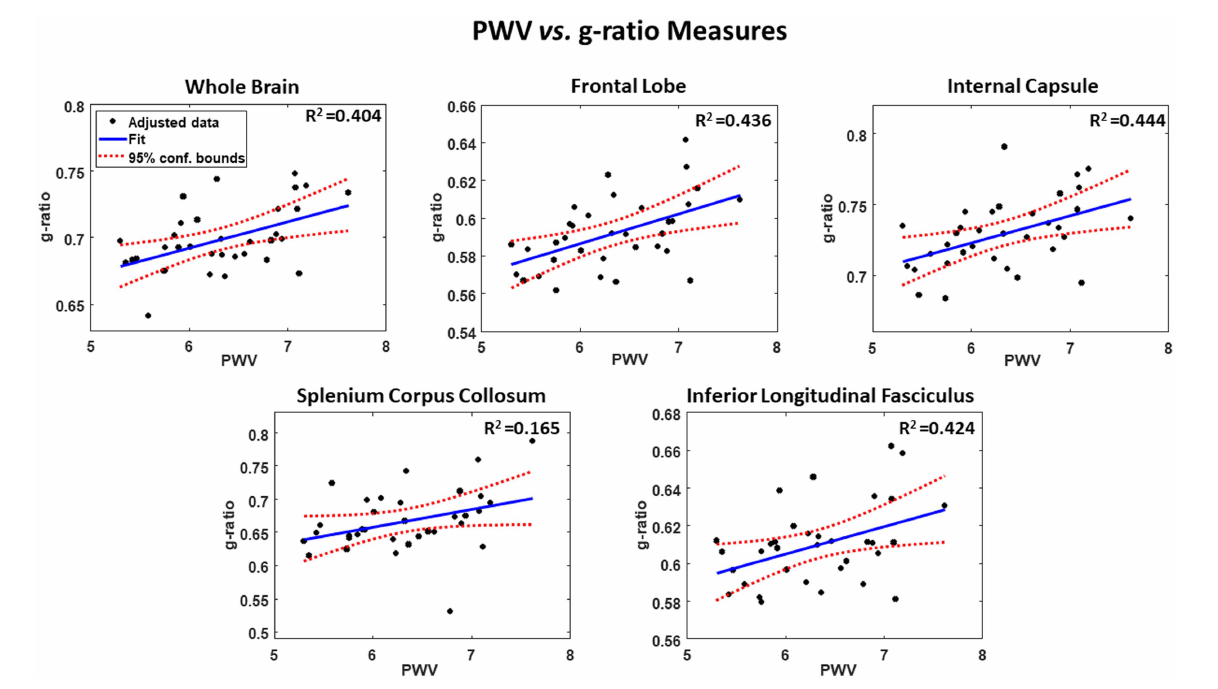
FIGURE 1 Example of regressions of g -ratio with pulse wave velocity (PWV), adjusted for age, sex, smoking, and SBP. Results are shown for 5 representative cerebral structures. For each plot, the coefficient of determination, R 2 , the line of best fit (blue solid line) and confidence intervals (red dashed lines) are